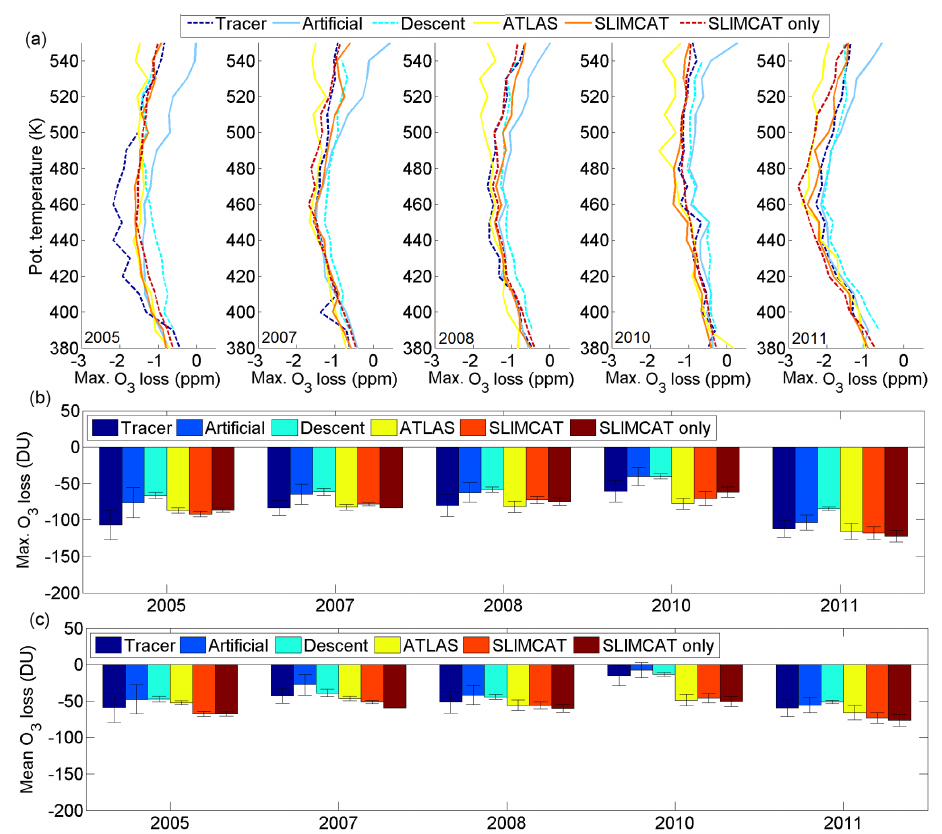
Figure 9. Same as Fig. 6, but for the comparison of all different methods: tracer-tracer correlation (blue), artificial tracer correlation (light blue), average vortex profile descent technique (cyan), passive subtraction with ATLAS (yellow), passive subtraction with SLIMCAT (or- ange), and passive subtraction using only modelled ozone from SLIMCAT (dark red). An average using different tracers is used for the tracer-tracer correlation, the artificial tracer correlation, and the average vortex profile descent technique; see text for